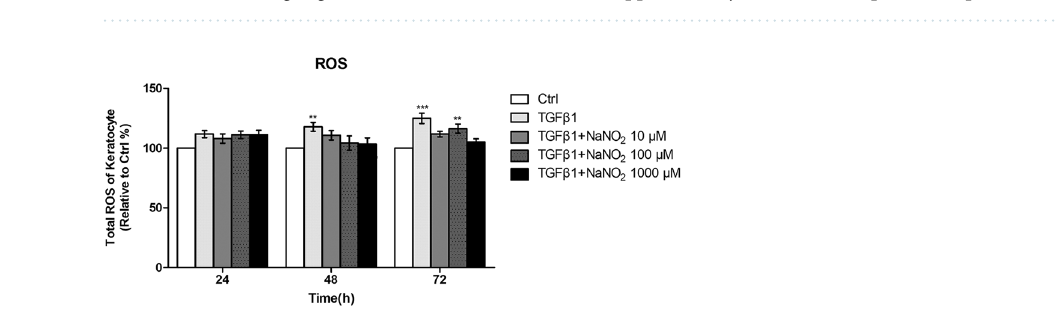
Figure 4. Myofibroblast marker expression by TGFβ1 stimulation in keratocytes. ( A ) Western blot analysis after 24 h TGFβ1 stimulation. TGFβ1 increased αSMA and N-cadherin expression from keratocytes. Smad3 phosphorylation is also increased with TGFβ1 stimulation. ( B ) Immunocytochemical staining revealed enhanced αSMA positivity (green: αSMA, red: F-actin, blue: DAPI, white bar: 50 μm) with higher concentrations of TGFβ1 stimulation for 72 h. Note that only the bands at the adequate molecular weights were shown here. Full length gel and blots are included in the Supplementary Information. *p < 0.05, **p < 0.01.